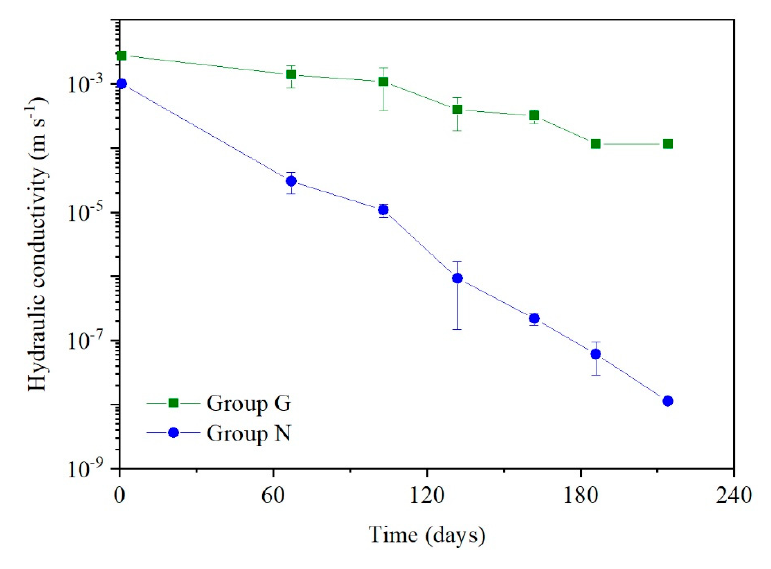
Figure 4. The hydraulic conductivity variation of the groups G and N.